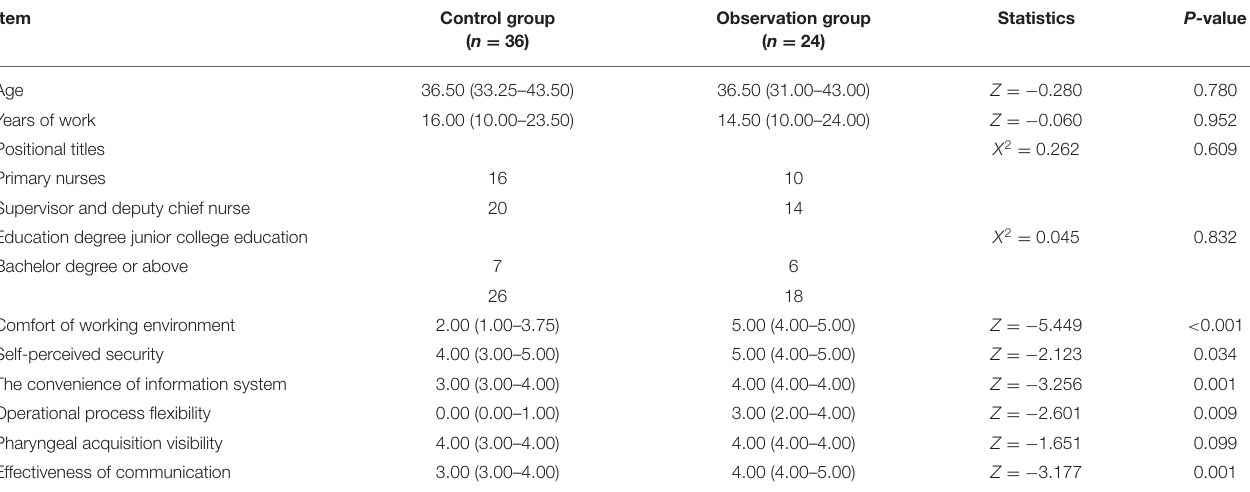
TABLE 1 | Comparison of the two groups of nurses with different work